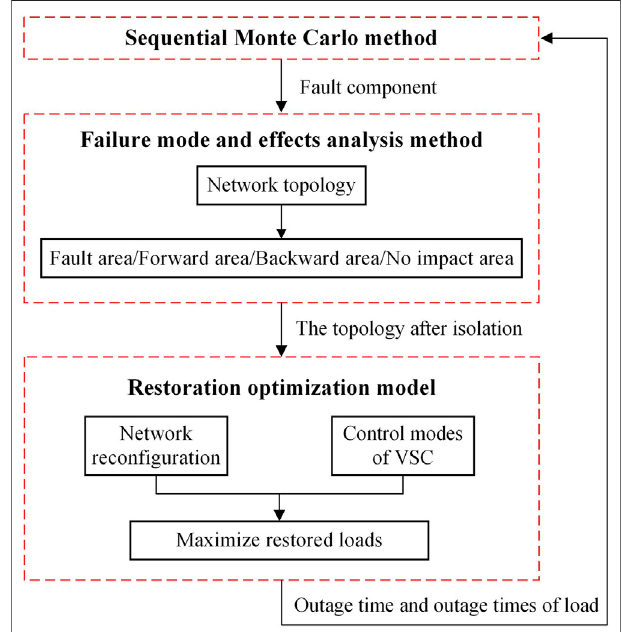
FIGURE 2 | Overall framework of the reliability evaluation method of the AC/DC hybrid distribution